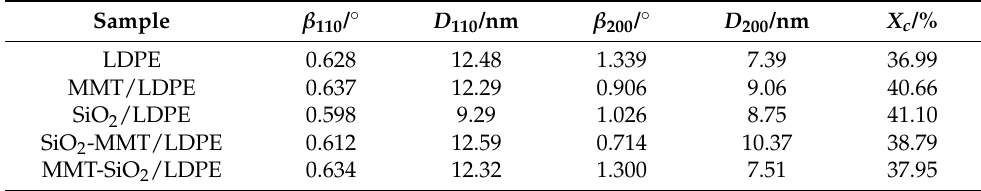
Table 2. XRD parameters of each